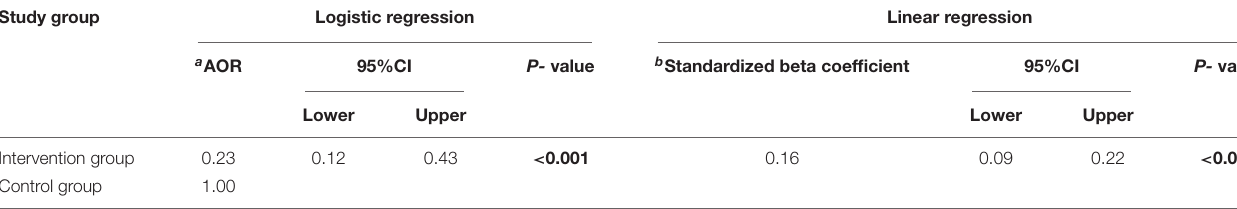
TABLE 4 | Regression analysis for the effectiveness of integrated nutrition intervention on low birth weight. Study group